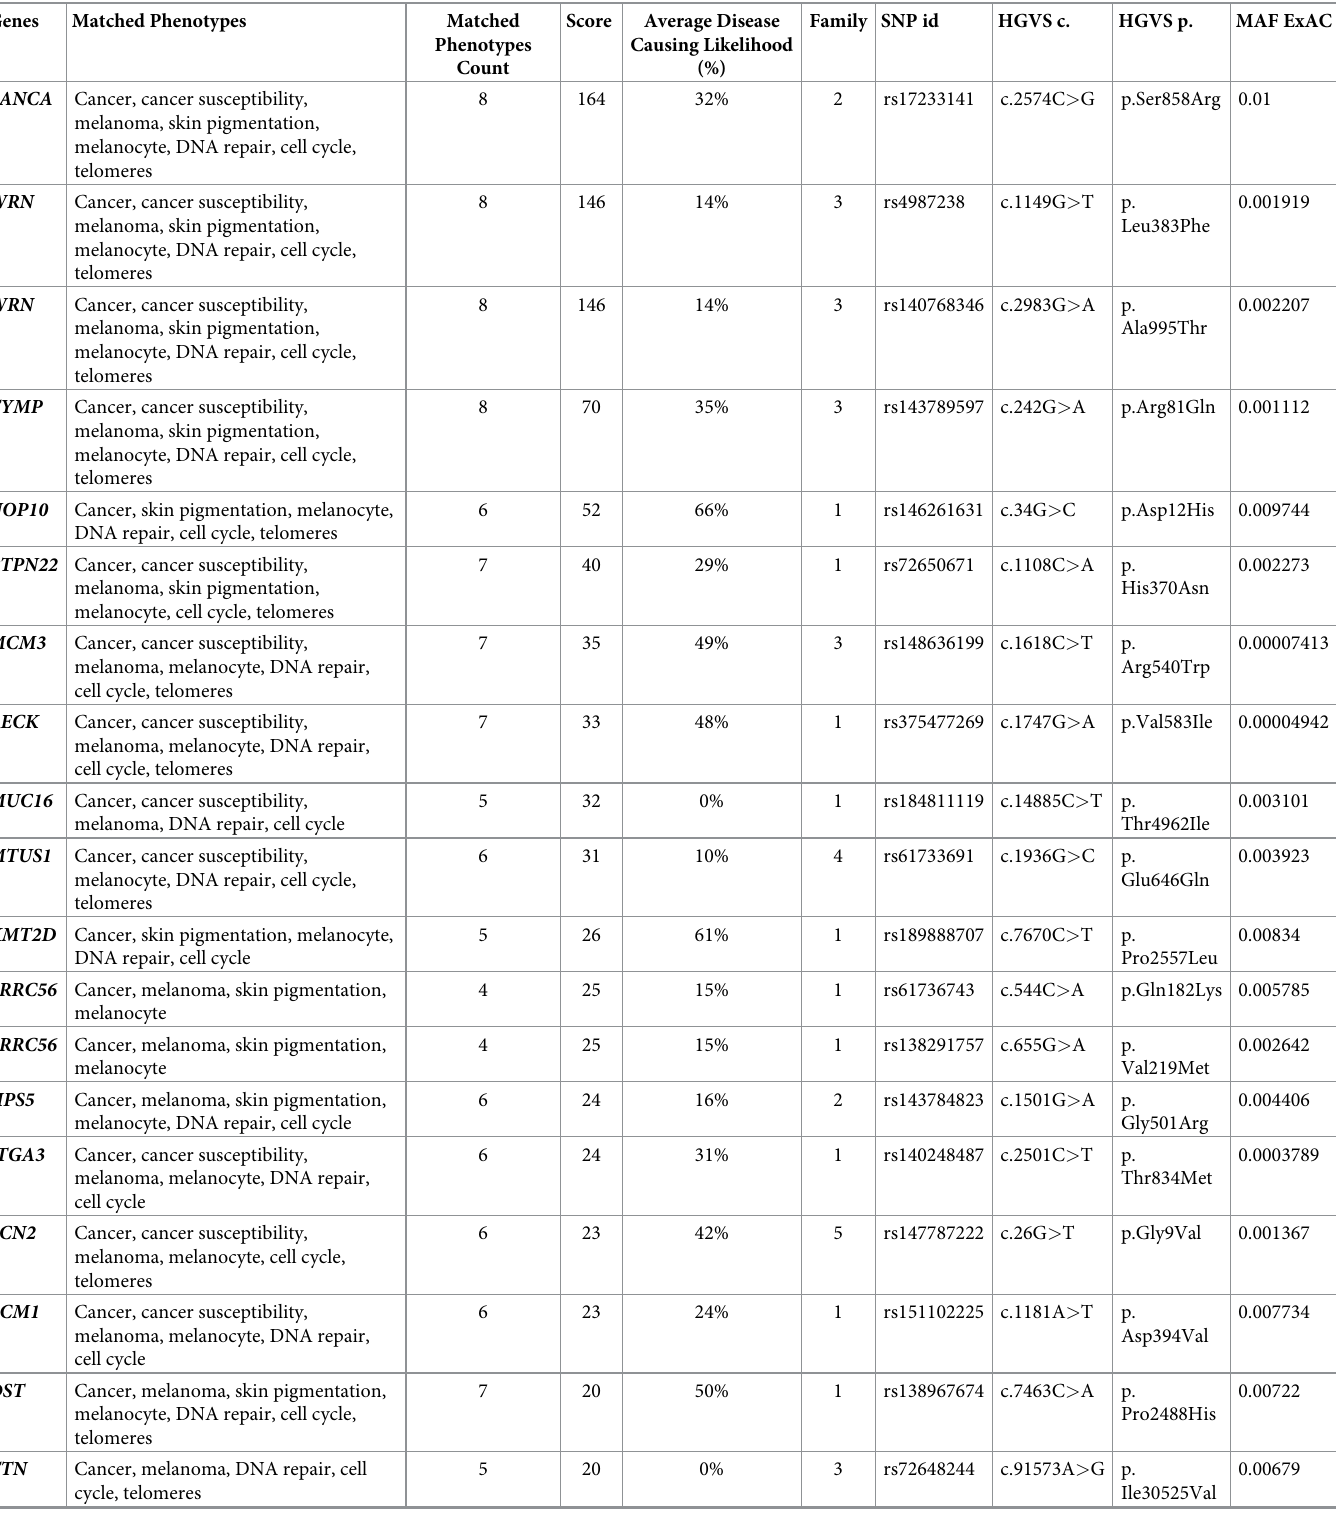
Table 5. Detected genes associated with the phenotypes of interest and their respective rare non-synonymous